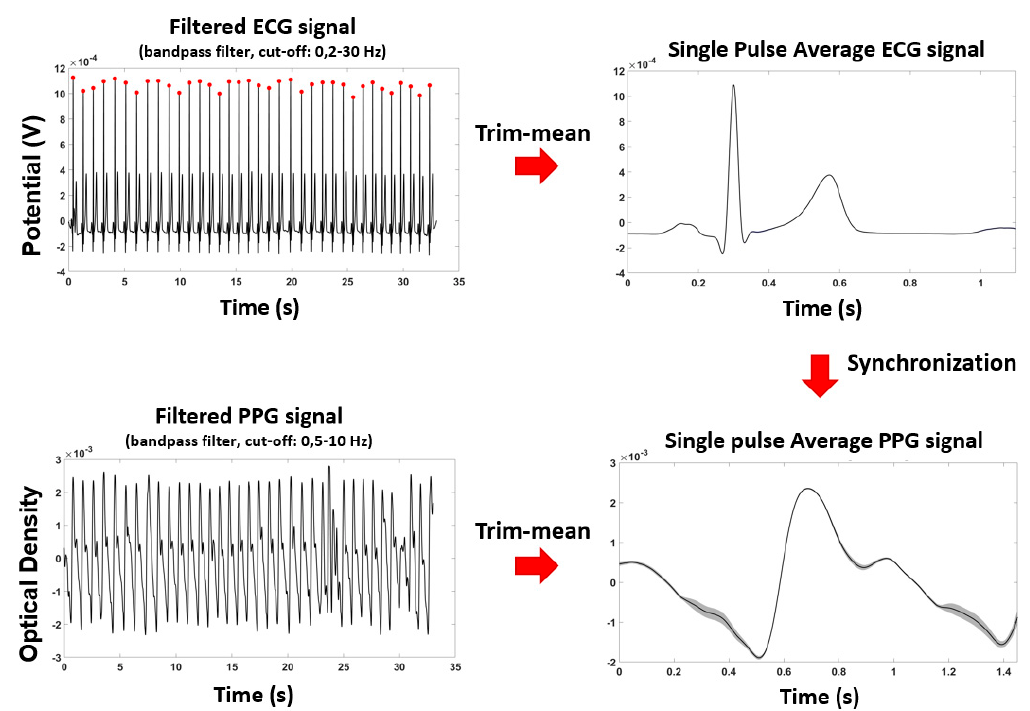
Figure 3. Preprocessing steps for ECG and PPG signals and an example of pulse average ECG and PPG and their standard errors (shaded areas), showing the small variability of the signals.